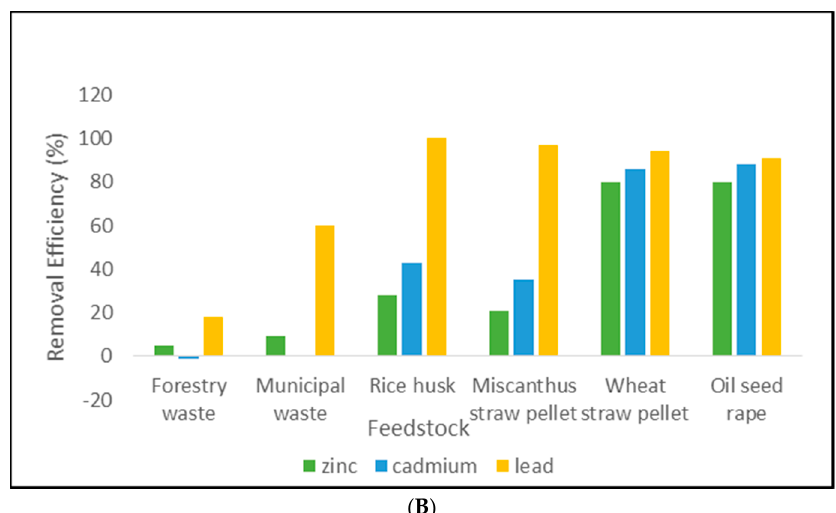
Figure 6. Column charts showing the removal efficiency of biochar at pyrolysis temperatures of ( A ) 550 °C and ( B ) 700 °C for Zn, Cd and Pb [25].